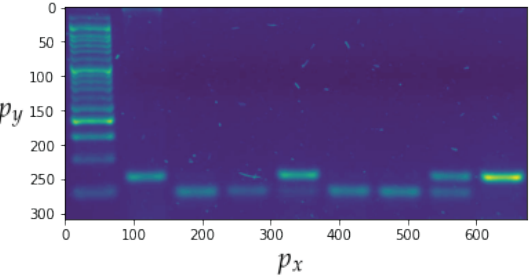
Figure 14. Image of the electrophoresis gel where p x is the position of the horizontal pixel and p y the position of the vertical pixel.